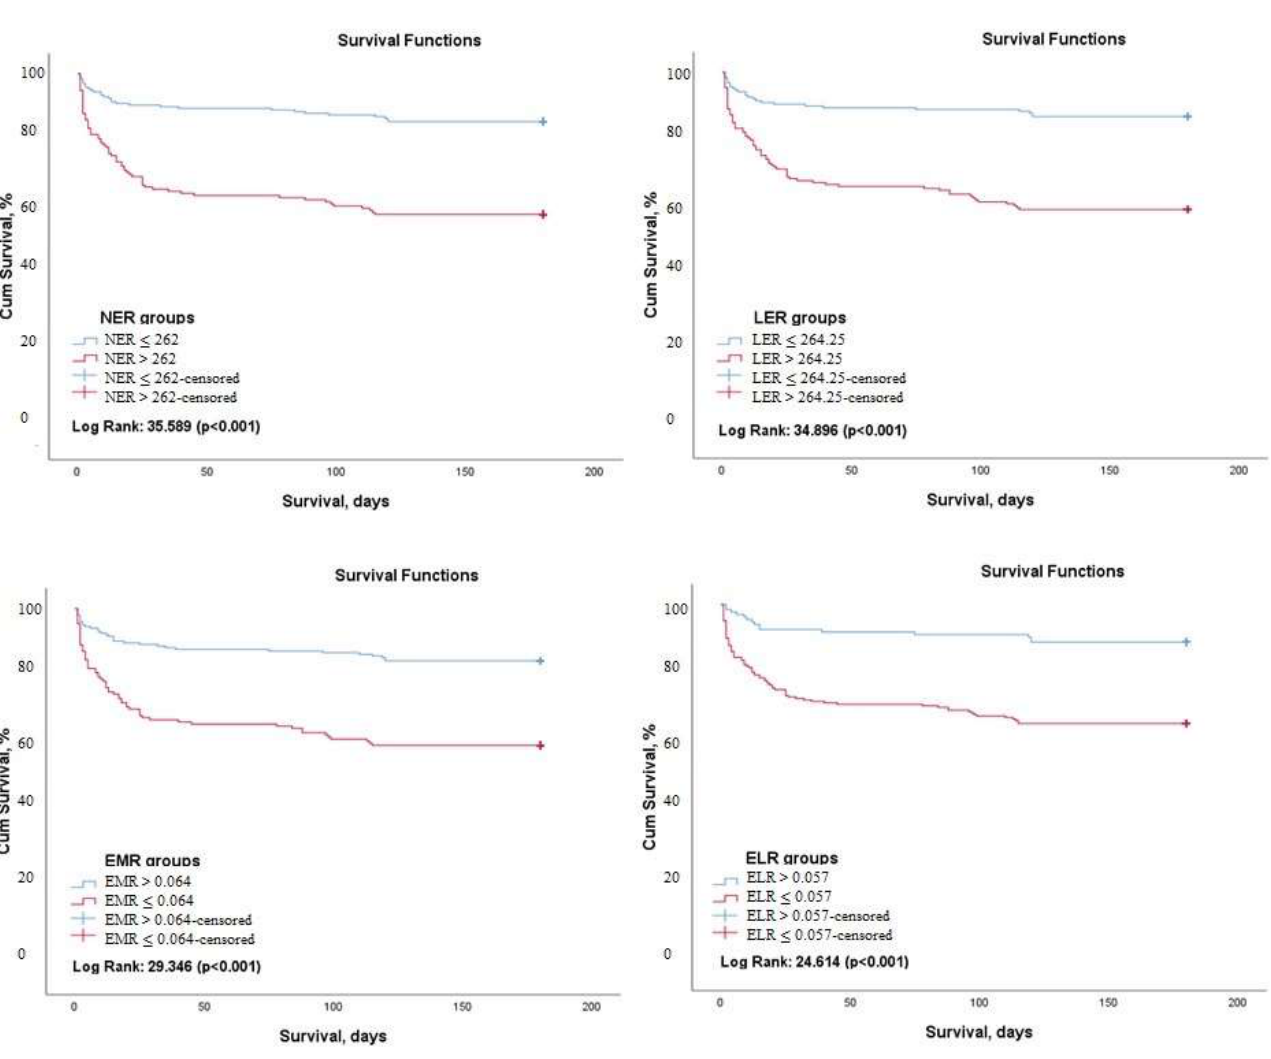
Figure 1. Kaplan–Meier survival analysis demonstrating 6 months mortality free survival according to NER, LER, EMR, and ELR (NER: Neutrophil-to-Eosinophil ratio, LER: Leukocyte-to-Eosinophil Ratio, EMR: Eosinophil-to-Monocyte Ratio, ELR: Eosinophil-to-Lymphocyte ratio). ROC curve analysis indicated that a cut-off value of 102.46 for NER (AUC: 0.699, 95% CI: 0.571–0.681, p < 0.001), 137.02 for LER (AUC: 0.616, 95% CI: 0.560–0.671, p < 0.001), 0.045 for absolute eosinophil count (AUC: 0.615, 95% CI: 0.559–0.670, p < 0.001), 0.134 for EMR (AUC: 0.586, 95% CI: 0.529–0.643, p = 0.003), 0.057 for ELR (AUC: 0.572, 95% CI: 0.515–0.628, p = 0.015) 5,26 for neutrophil (AUC: 0.590, 95% CI: 0.535–0.646, p = 0.001) and 0.89 for lymphocyte (AUC: 0.601, 95% CI: 0.575–0.687, p < 0.001) could be used to estimate the 6-month MACE development with acceptable sensitivity and specificity (Table 3).